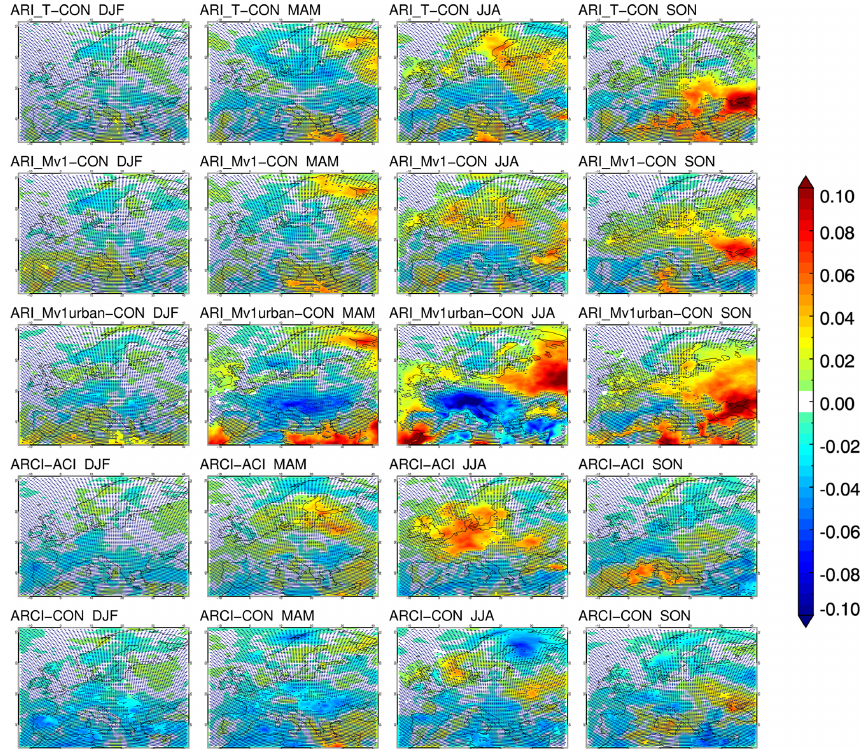
Figure 6. Total cloud fraction (CFRACT) change for all seasons. Rows 1–3: for selected ARI group simulations (ARI_T, ARI_Mv1, ARI_Mv1urban) that implement only aerosol–radiation interactions. The CFRACT change has been calculated against control CON and depicts the impact of aerosol–radiation interactions only. The fourth row depicts the aerosol–radiation interactions in an environment where the indirect effect is also present and displays the difference of experiment ARCI to ACI. The bottom row depicts the impact of aerosol– radiation interactions plus the impact of the TE2014 microphysics scheme with aerosol–cloud interactions. It displays the difference of experiment ARCI to CON. Stippling indicates areas where the differences are not statistically significant at the 95% level, according to the Mann–Whitney non-parametric